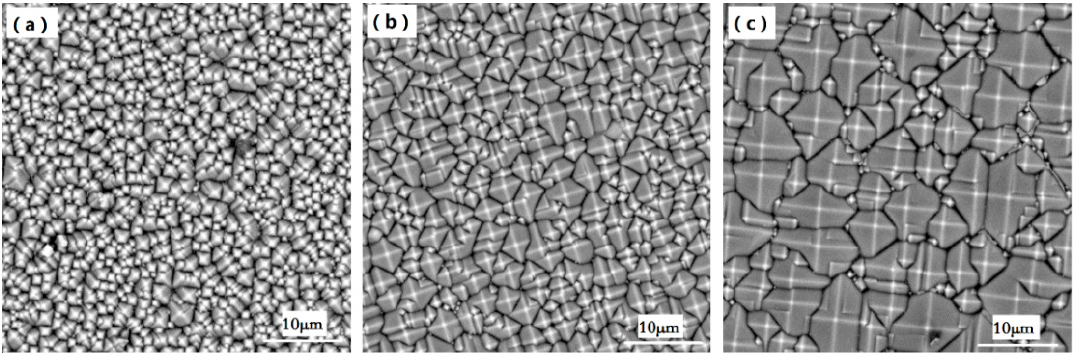
Figure 1. Three typical pyramidal textures obtained by a chemical etching process: ( a ) Initial etching, ( b ) moderate etching, ( c ) excessive etching.